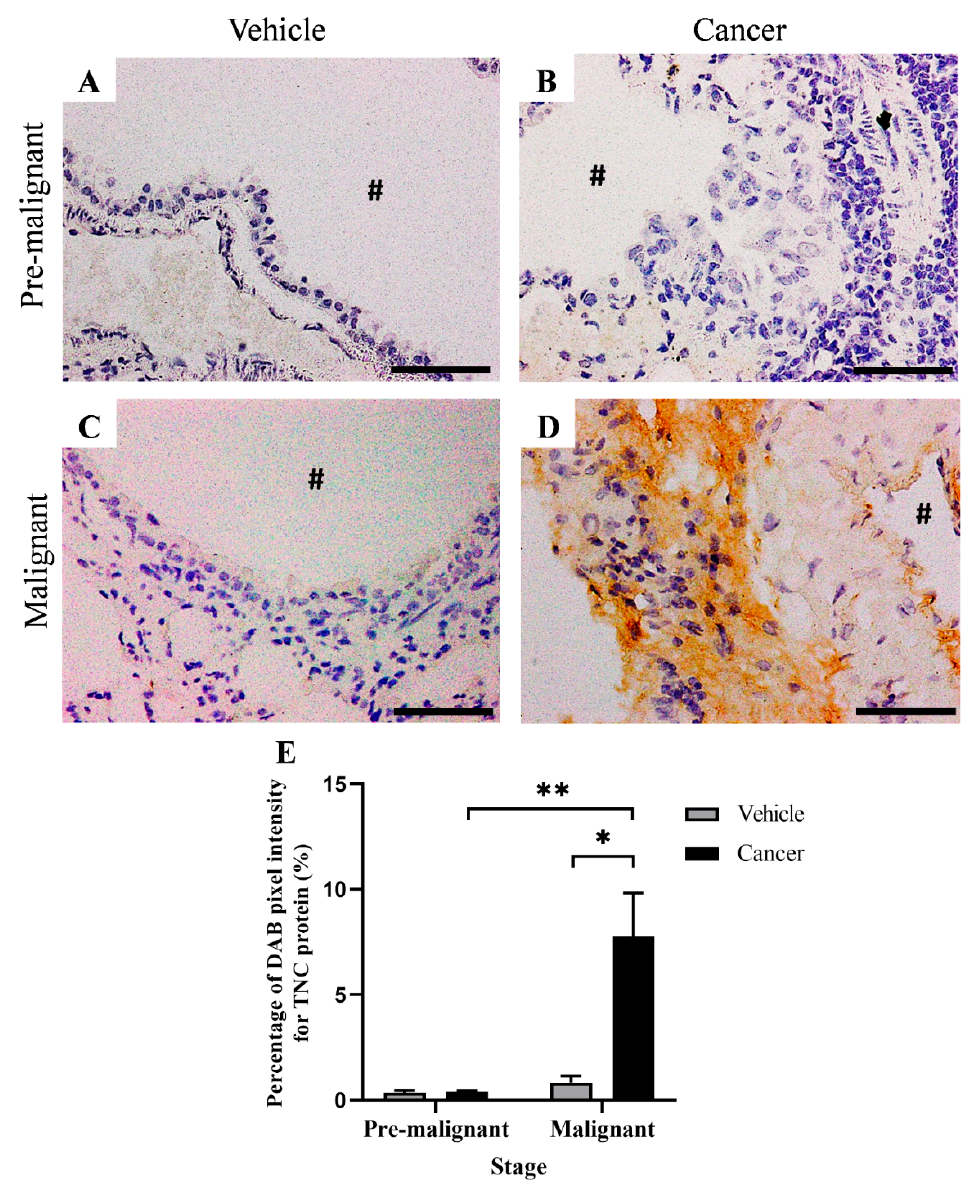
Figure 5. Immunohistochemistry (IHC) staining for TNC protein at the bronchial area of the Vehicle and Cancer groups from both stages of carcinogenesis, at 40× magnification. ( A , C ) showed IHC staining of normal bronchial ( B ) showed IHC staining of Pre-malignant lung SCC tissue with no observable DAB brown staining. ( D ) showed IHC staining of Malignant lung SCC tissue with an observable DAB brown staining at the extracellular matrix around the bronchial. ( E ) showed the percentage of the IHC staining in the Vehicle and Cancer groups from both stages of carcinogenesis. Data are presented as mean ± SEM. # is the airway lumen. Scale bars = 50 µm. * is a significant difference ( p < 0.05) between groups in the same stage. ** is a significant difference ( p < 0.05) between Cancer groups from different stages of carcinogenesis. p < 0.05 using Student’s t -test.